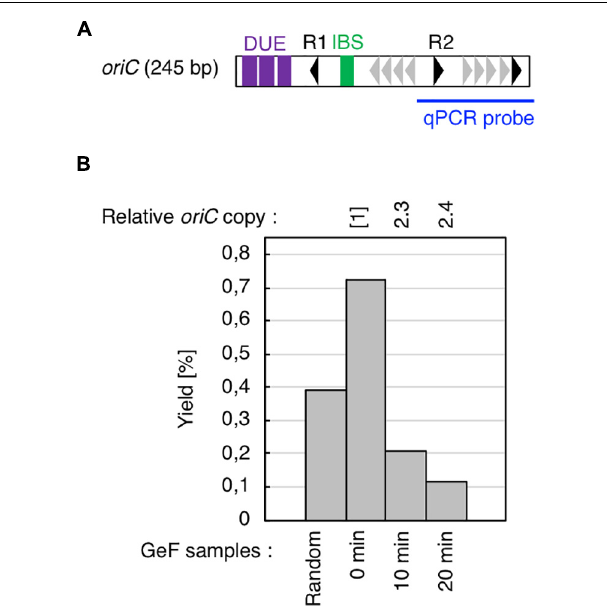
FIGURE 2 | Cell cycle-specific IHF binding at oriC in GeF-qPCR. (A) Amplified region of oriC in qPCR experiments. Symbols used for oriC structure are shown as in Figure 1B . (B) IHF-GeF-qPCR of oriC . SH022 ( dnaC2 ihfA-cHis12 ) cells growing at 30 ◦ C were transferred to 38 ◦ C and incubated for 90 min. The cells were then transferred to 30 ◦ C (Time 0) and further incubated for 10 or 20 min at 30 ◦ C. The relative oriC levels before and after Ni-affinity purification were determined using real-time qPCR, and yield was calculated (expressed as %). In addition, relative copies of the chromosomal oriC and TerC loci in the Input samples were quantified; the relative ratios of oriC / ter are expressed relative to the ratio at 0 min (determined as 1).